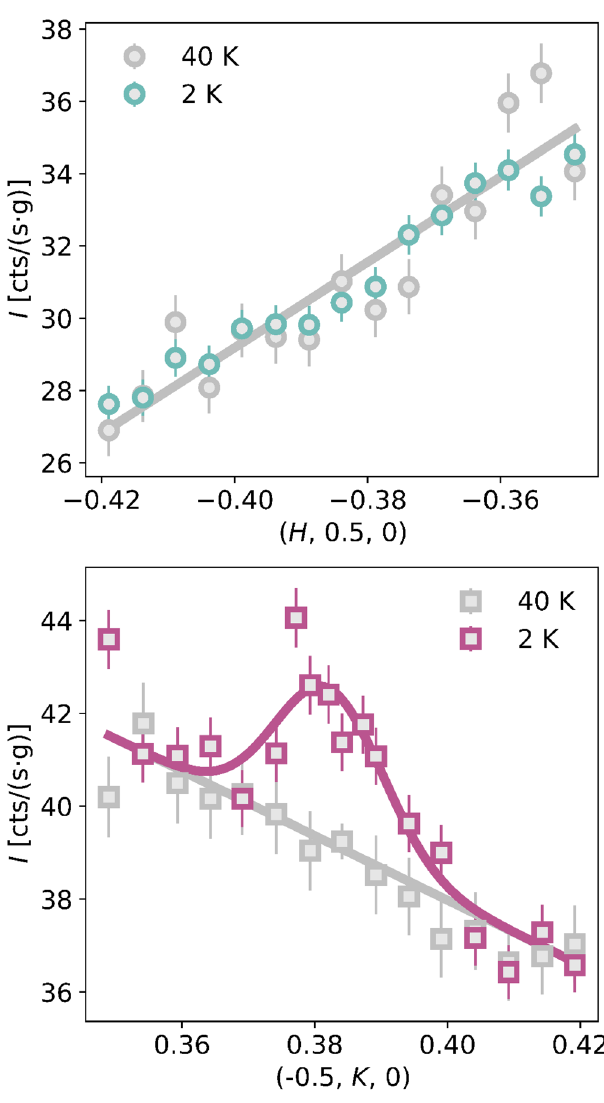
Fig. 3 Single magnetic domain state under uniaxial pressure. Reciprocal space scans of La 1 : 88 Sr 0 : 12 CuO 4 under compressive a -axis strain measured at T = 2 and 40 K. Intensities ( I ) are given in counts (cts) per seconds (s) and mass (g) of the sample. Error bars are dictated by Poisson statistics. Scans through Q a and Q b reveal a single-domain state. The high- SDW SDW temperature data were fi tted with a sloping background. The low- temperature data for the Q b -domain were fi tted to a Gaussian line shape SDW over the fi xed high-temperature